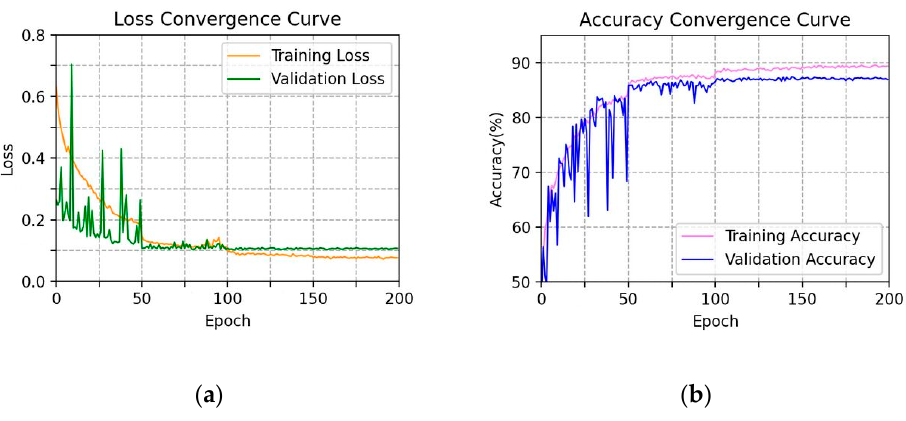
Figure 4. ( a ) Loss convergence curve; ( b ) accuracy convergence curve.